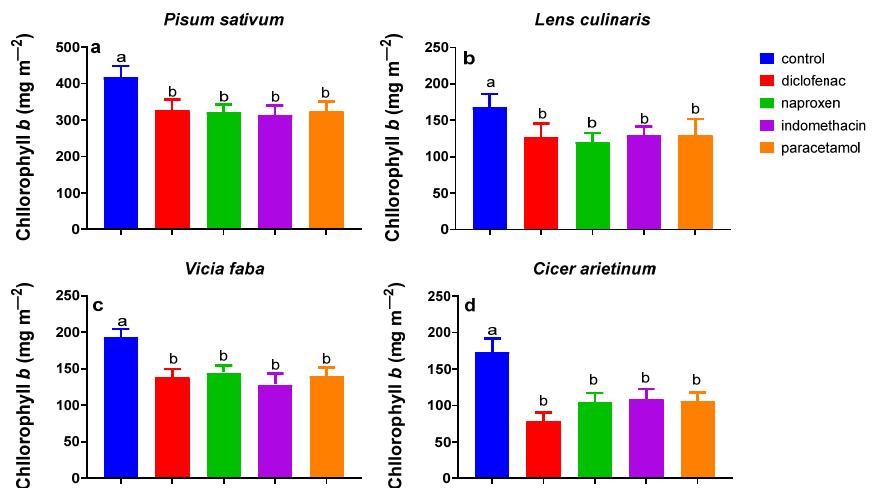
Figure 6. Chlorophyll b concentration from Pisum sativum ( a ), Lens culinaris ( b ), Vicia faba ( c ), and Cicer arietinum ( d ). Plants in 0.5 L pots filled with commercial garden soil were treated by watering 100 mL of 0.5 mg L − 1 NSAIDs every second day over a total of 20 days. The values are averages of four independent measurements. Data sharing different letters are significantly different ( p < 0.05), while data sharing the same letters are not significantly different ( p > 0.05).